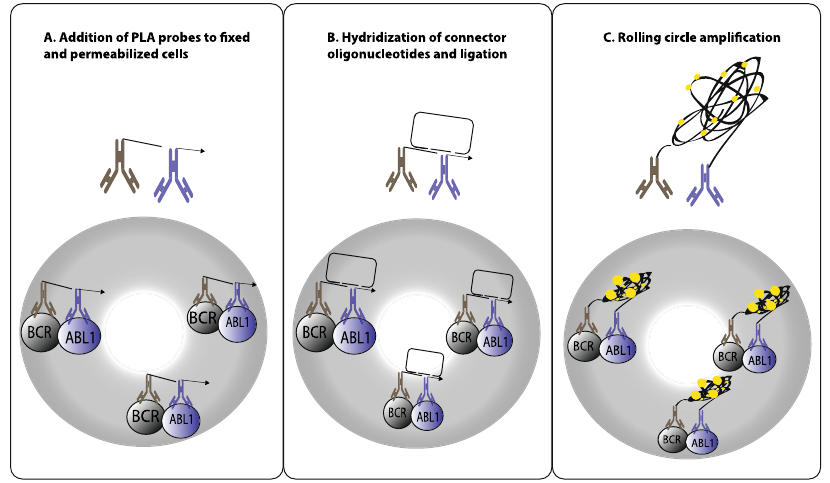
Figure 1. Detection of cells expressing BCR-ABL1 with PLA-flow. The assay employs a pair of oligonucleotide- conjugated antibodies (PLA probes) with affinity for the BCR and ABL1 domains of the fusion protein in fixed and permeabilized cells ( A ). The oligonucleotides on PLA probes remaining in close proximity after washes serve as templates for hybridization of two additional DNA oligonucleotides, guiding their ligation into DNA circles ( B ). After ligation, the DNA circles are locally amplified by rolling circle amplification (RCA) to generate RCA products that are visualized and detected by addition of complementary fluorophore-labeled oligonucleotides ( C ), followed by detection of labeled cells via flow